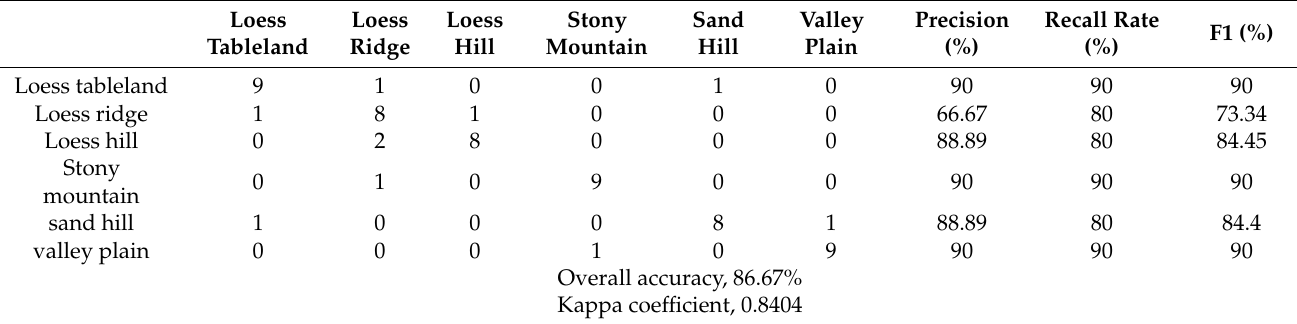
Table 5. The confusion matrix produced by the fusion datasets of the terrain derivatives and texture derivatives. Noted that the fusion datasets included average slope, variance of slope, variance of curvature, entropy of slope, average slope of slope, elevation range, hillshading entropy, slope entropy, elevation variance, standard deviation of slope of slope, standard deviation of curvature, hillshading contrast, and the maximum